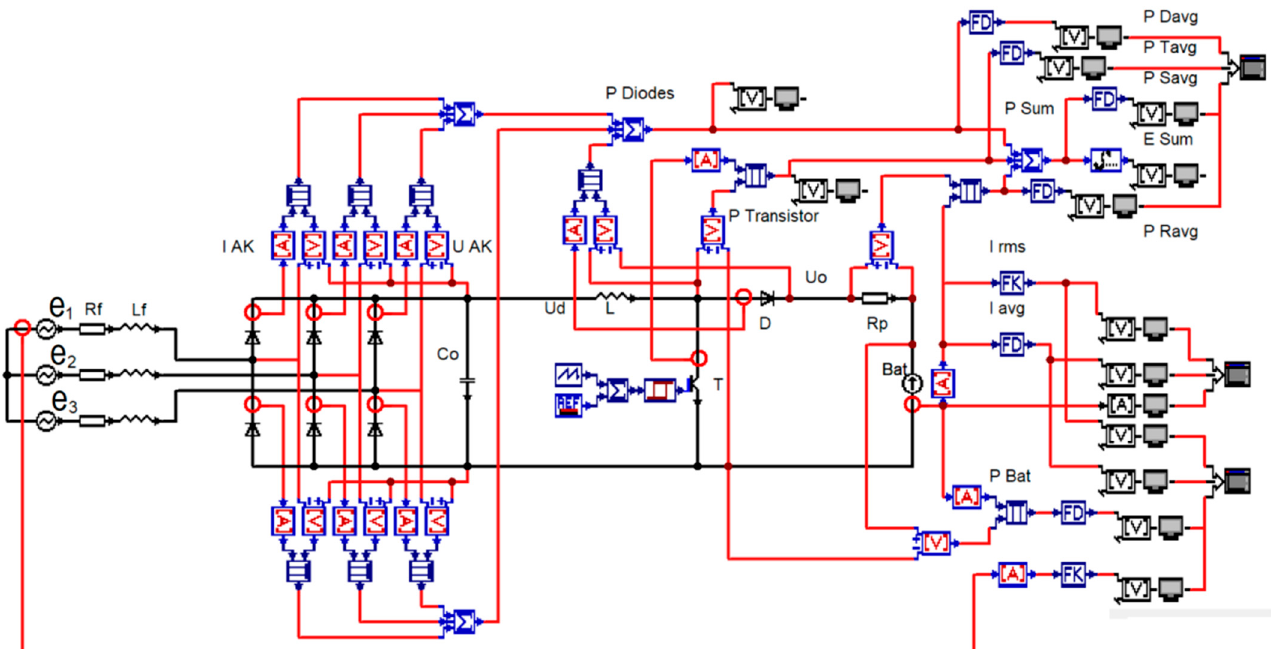
Figure 5. Simulation circuit of the tree-phase full bridge rectifier with the boost converter.